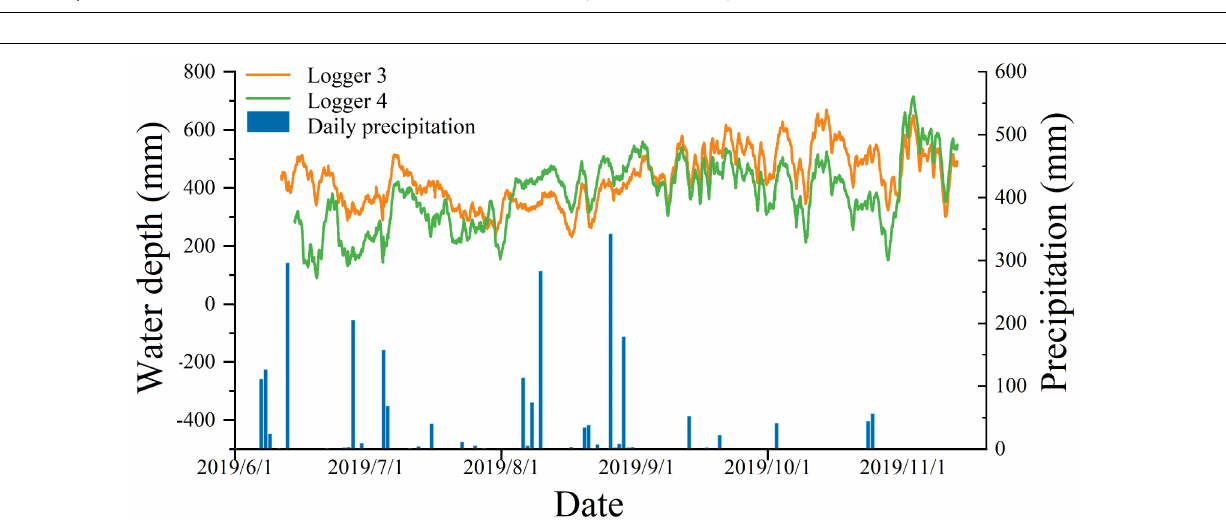
FIGURE 4 | Surface connection of Baihe Lake water on both sides of the road (within the red lines).